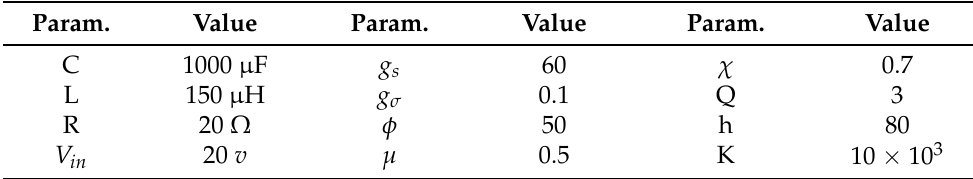
Table 1. Parameters of DC-DC buck